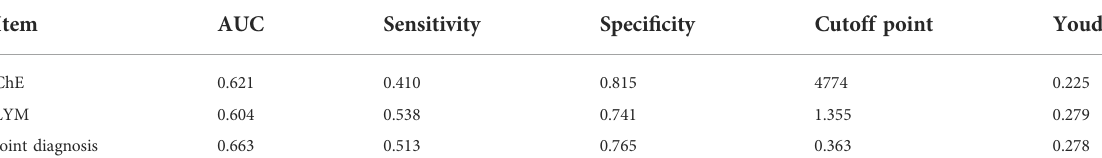
TABLE 5 Performance analysis of baseline ChE, LYM, and joint diagnosis.